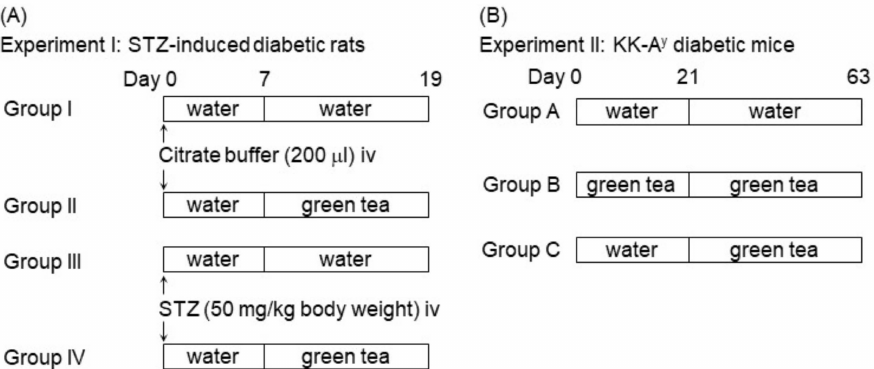
Figure 1. Experimental schedule. ( A ) Experiment I: Male Wistar / ST rats (6 weeks old) were allocated to two groups ( n = 10 each), one of which was injected with streptozotocin (STZ) (Groups III and IV) and the other with citrate buffer only (Groups I and II) for 7 days. Each group was further divided into two subgroups ( n = 5 each), one of which was administered green tea (Groups II and IV), while the other drank only water (Groups I and III). During the feeding period, body weight and blood glucose concentration were measured on Days 0, 7, 10, and 13. Then the rats were killed on Day 19. ( B ) Experiment II: KK-A y